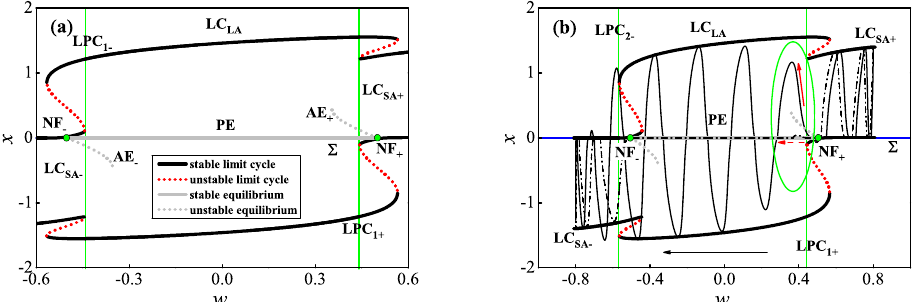
Figure 8. Rest spike bistabilities as well as the special transitions. ( a ) Rest spike bistabilities in the fast subsystem (4) as well as their bifurcations; ( b ) the superimposition of ( a ) and two different migration modes of whole system trajectories in the same evolution direction.